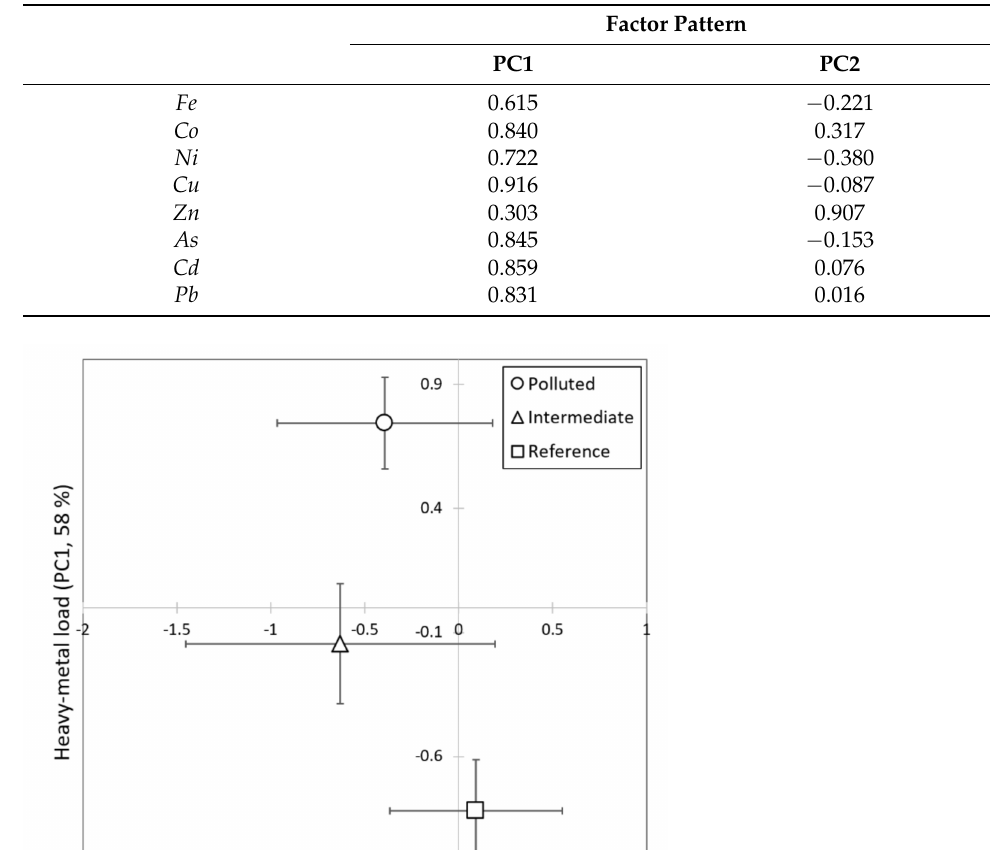
Table 2. Correlations between logarithmically transformed metal eigenvalues and two principal components (PC1 and PC2).